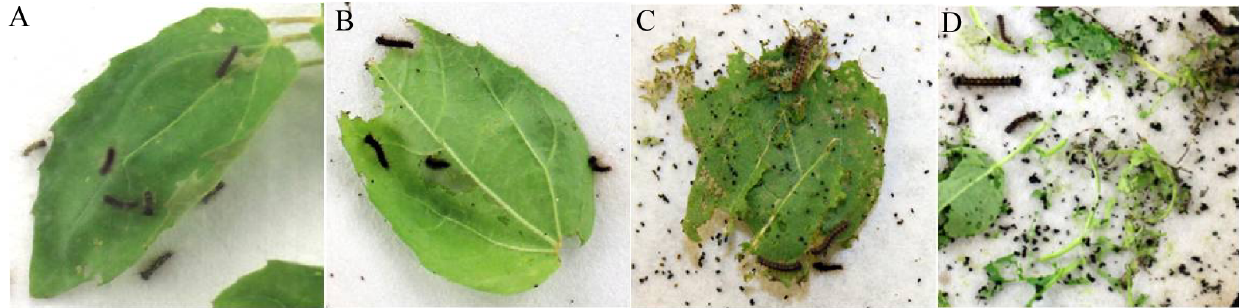
Fig 4. Poplar leaf bioassay against gypsy moth larvae after 7 d of feeding. (A) A3 (Cry1Ac and SCK). (B) B1 (Cry1Ah3). (C) C1 (Cry9Aa3). (D) wild type as control.